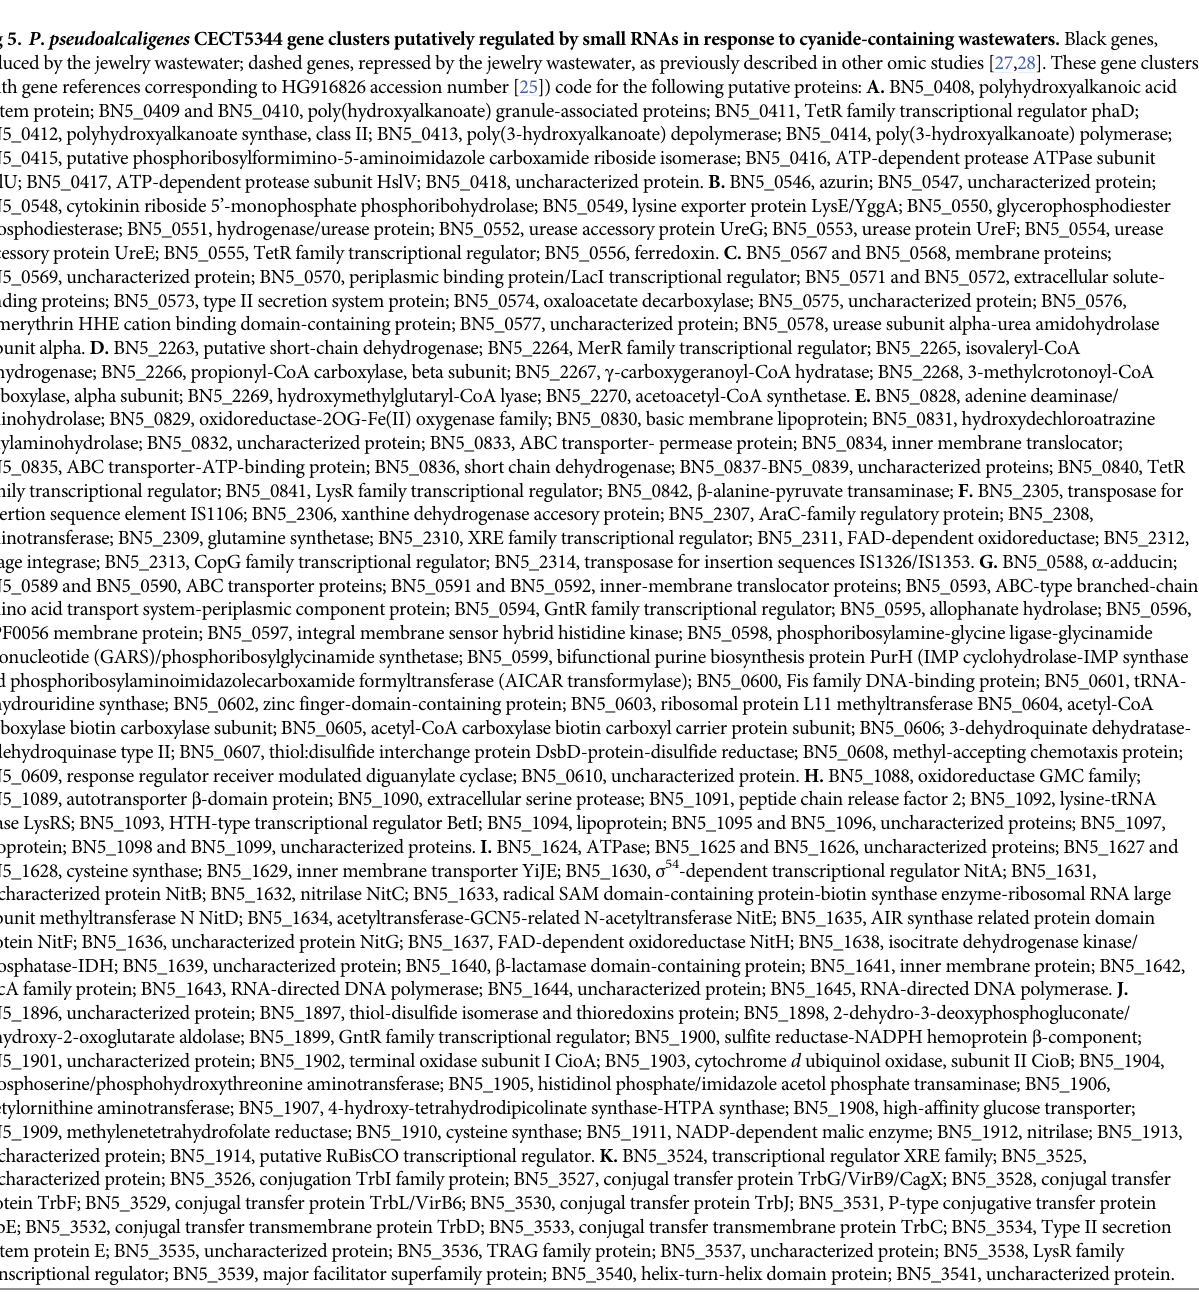
Fig 5. P . pseudoalcaligenes CECT5344 gene clusters putatively regulated by small RNAs in response to cyanide-containing wastewaters. Black genes, induced by the jewelry wastewater; dashed genes, repressed by the jewelry wastewater, as previouslydescribed in other omic studies [27,28].These gene clusters (with gene references corresponding to HG916826accession number [25])code for the following putative proteins: A. BN5_0408, polyhydroxyalkanoic acid system protein; BN5_0409 and BN5_0410, poly(hydroxyalkanoate) granule-associated proteins; BN5_0411, TetR family transcriptional regulator